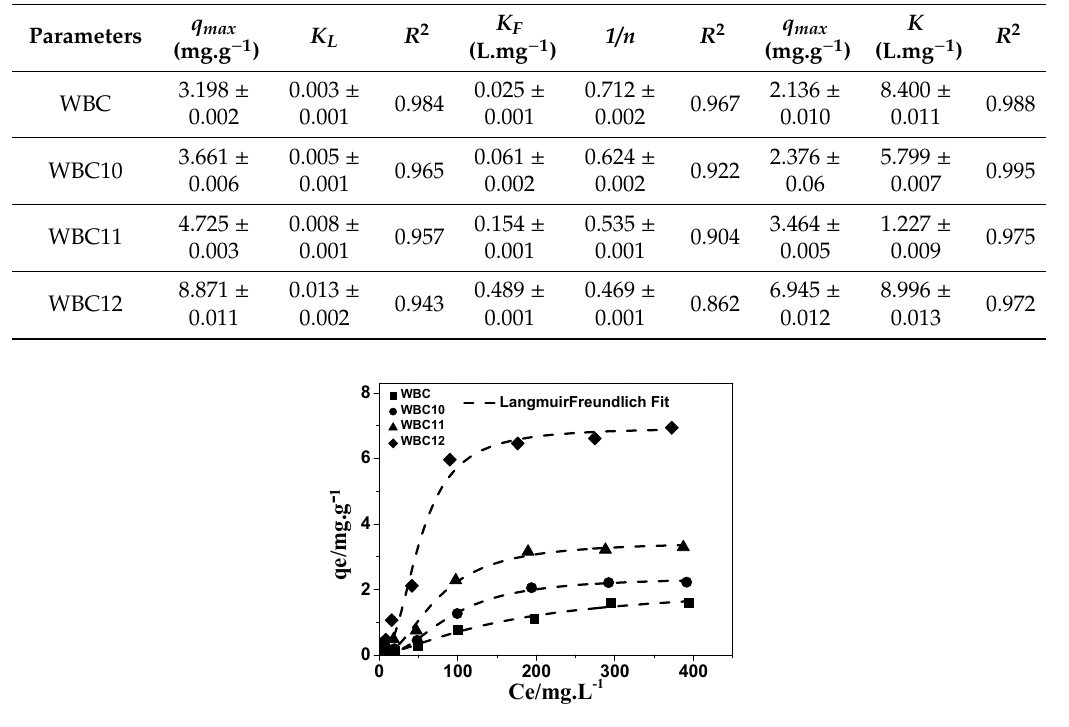
Table 3. Adsorption isotherm parameters of phosphate to WBC and WBC1x.